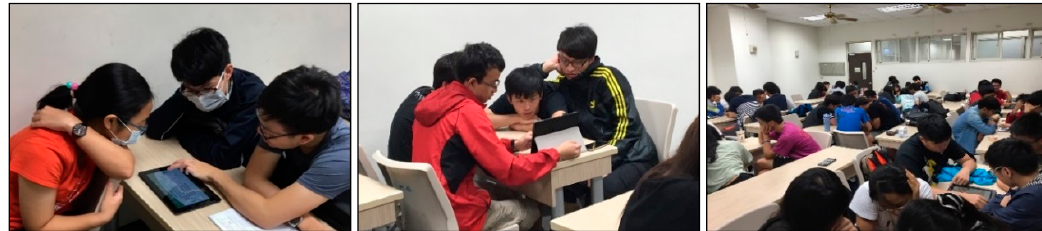
Figure 17. Teaching module used by the experimental group.